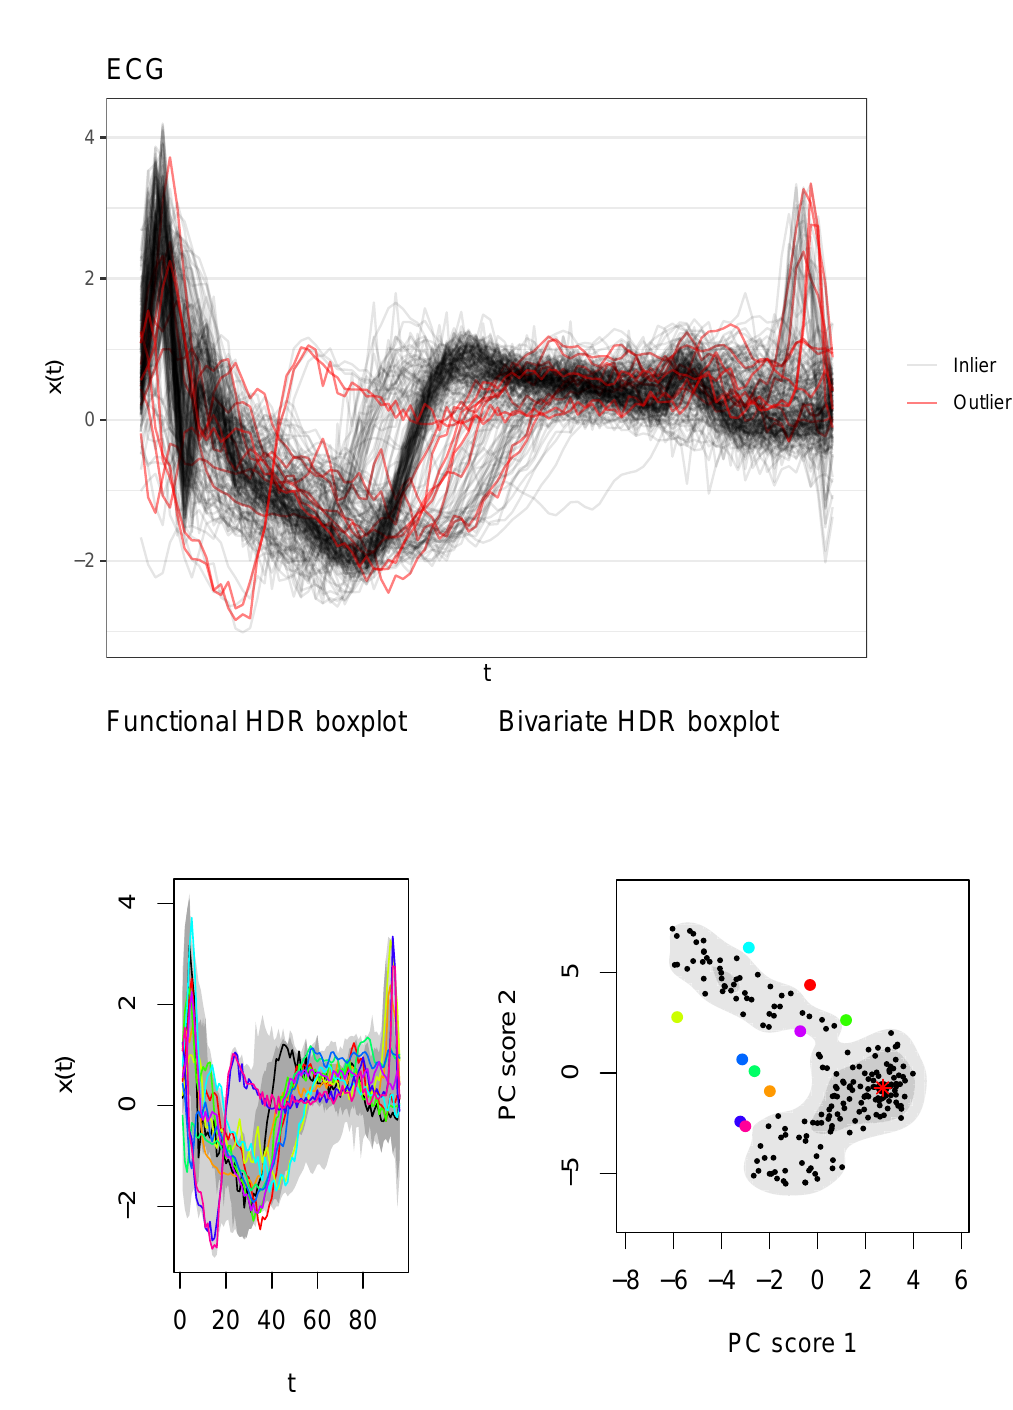
Figure A9. Upper row: ECG data. Lower row, left column: functional HDR boxplot; right column: bivariate HDR boxplot. Colored curves/points are outliers according to a coverage probability of 0.05 for the functional HDR boxplot. HDR boxplots computed with rainbow::fboxplot